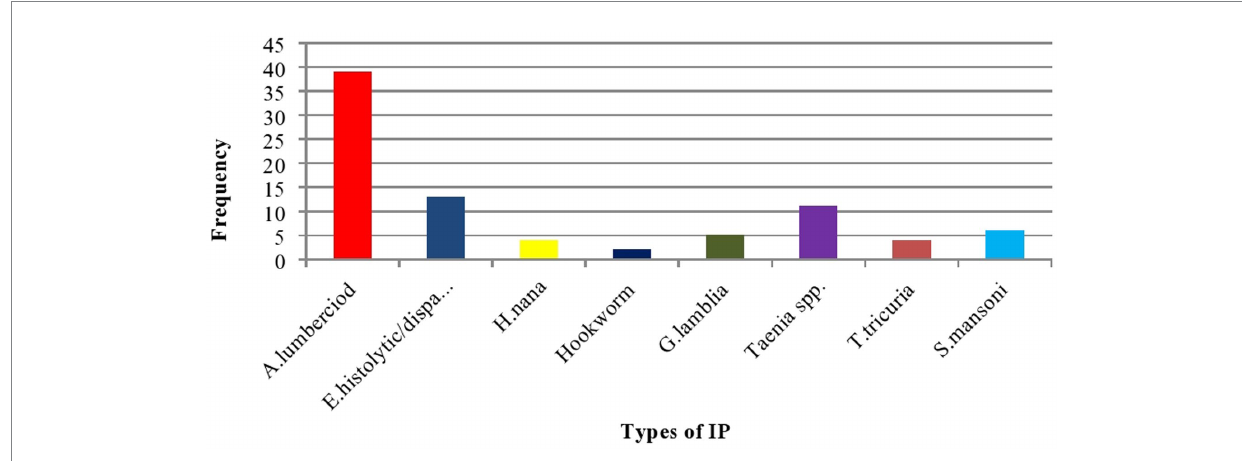
FIGURE 2 Bar graph showing the type of identified IP among postnatal women in Gondar town, Northwest Ethiopia, 2021 ( n =